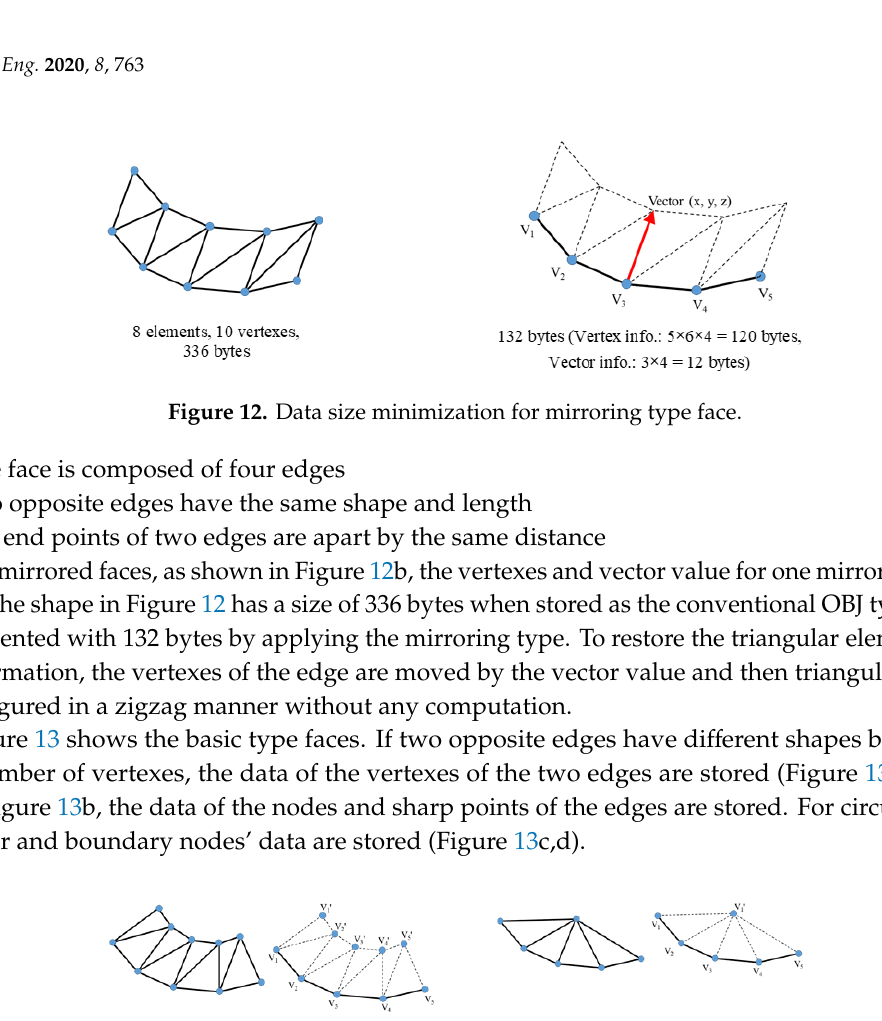
Figure 14. Same normal vectors of planes.